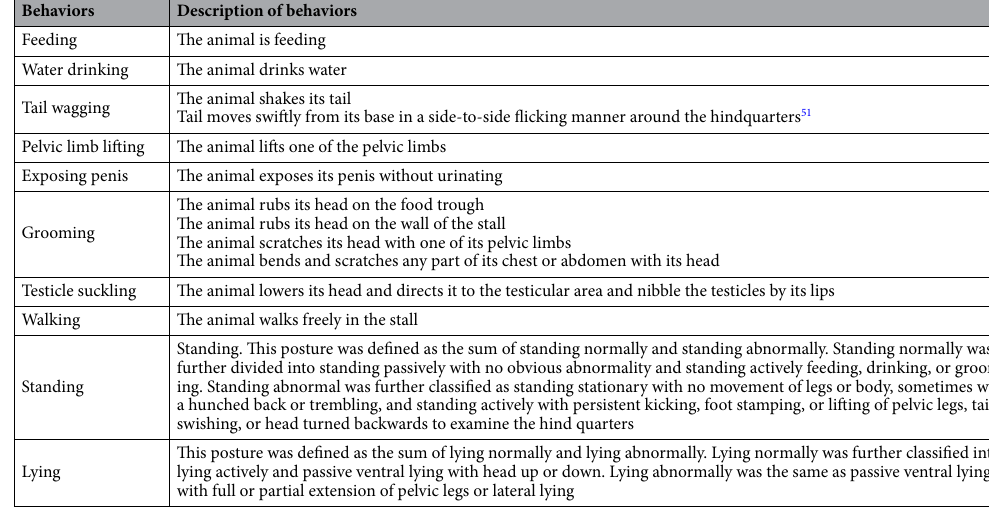
Table 1. Ethogram of donkeys subjected to subcapsular (SC) and open castration (OC) techniques and their description (Oliveira et al.,